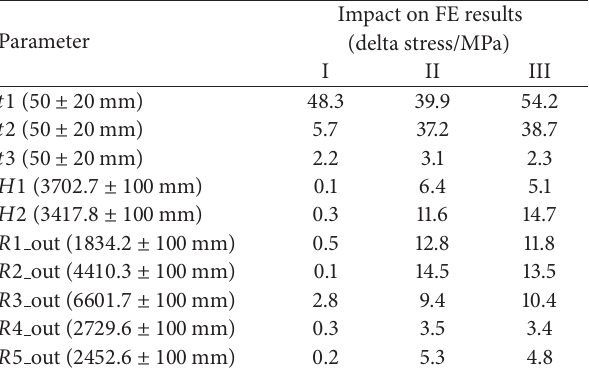
Table 2: Types of loads performed in VV module.